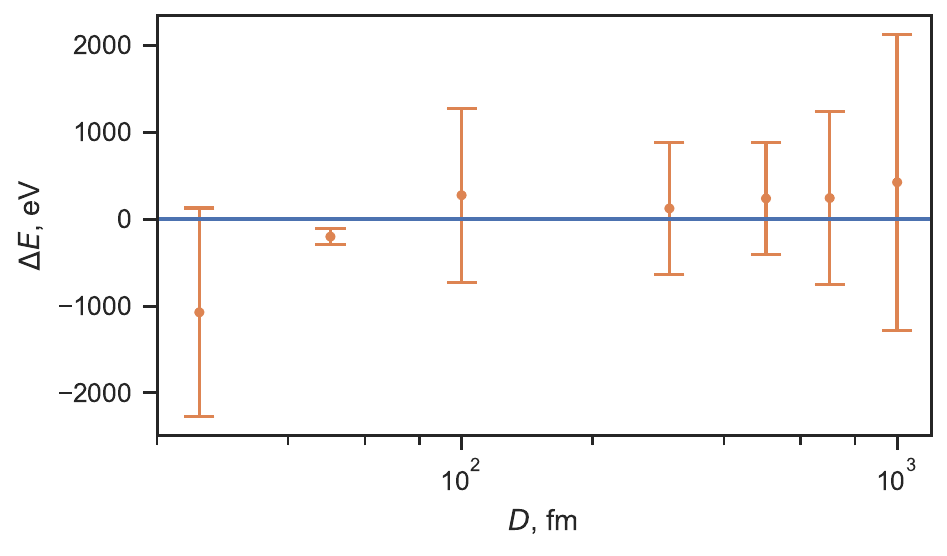
− E TC . See the text for details. 1 σ 1 σ